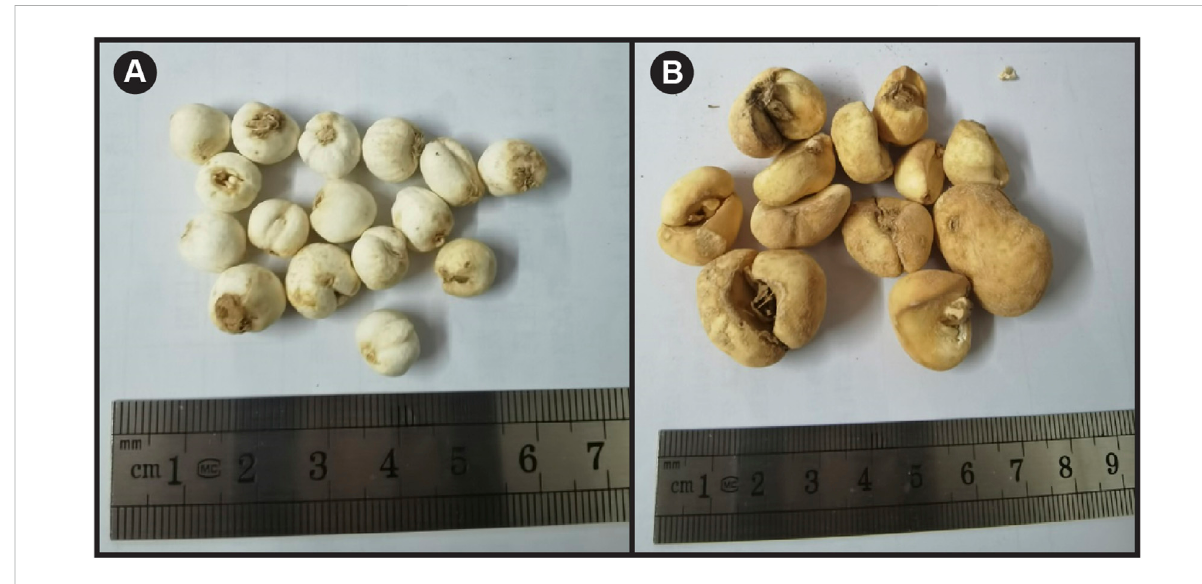
FIGURE 1 Photographs of the dried bulbs of (A) Fritillaria cirrhosa D. Don and (B) Fritillaria thunbergii